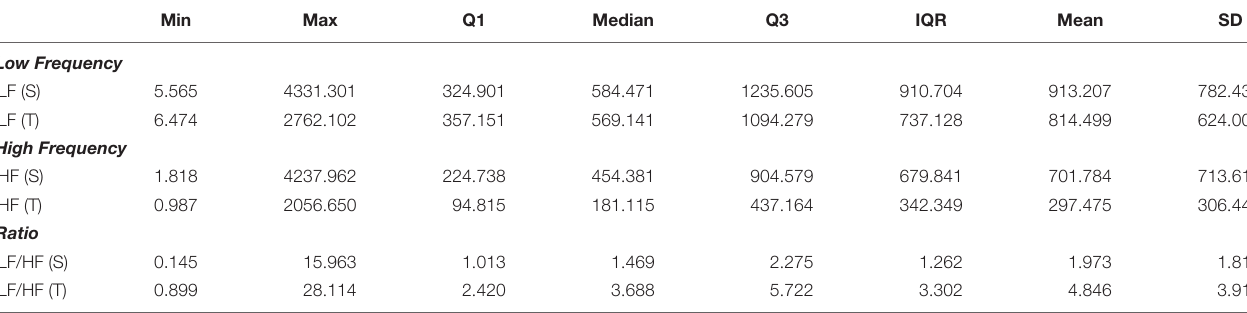
TABLE 2 | Power spectral analysis parameters in supine (S) and tilt (T) stages of HUTT.